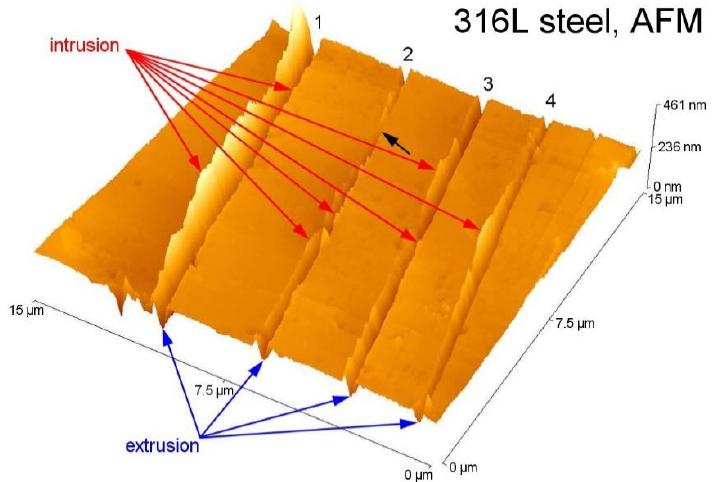
Figure 3. AFM image of the surface of 316L steel cycled to N = 2000 ( N = 4.3% N f ) with ε ap = 1 × 10 − 3 obtained using plastic replicas.